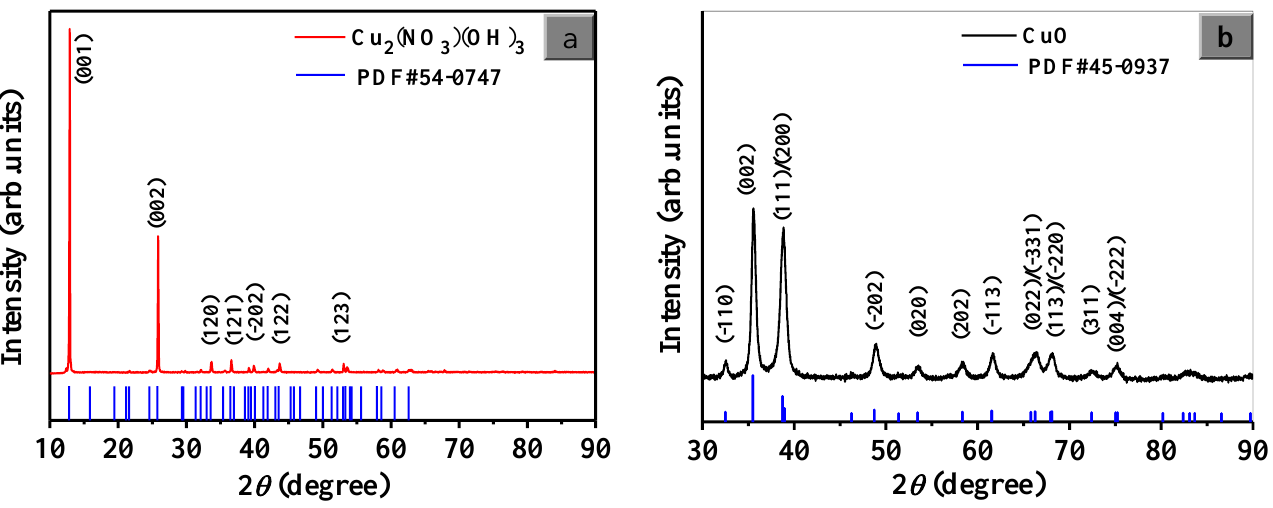
Figure 1. XRD patterns of ( a ) Cu 2 (NO 3 )(OH) 3 and ( b ) CuO.